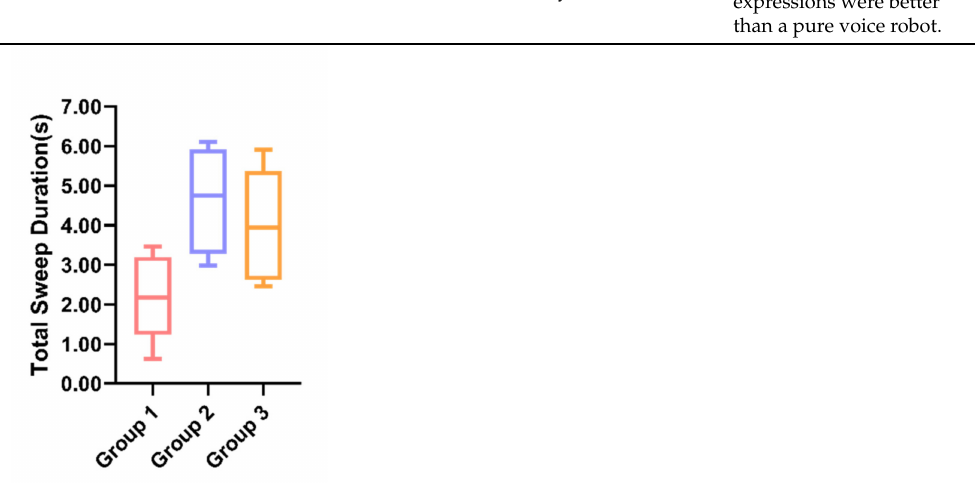
Figure 3. Individual differences in the total sweep duration between the three